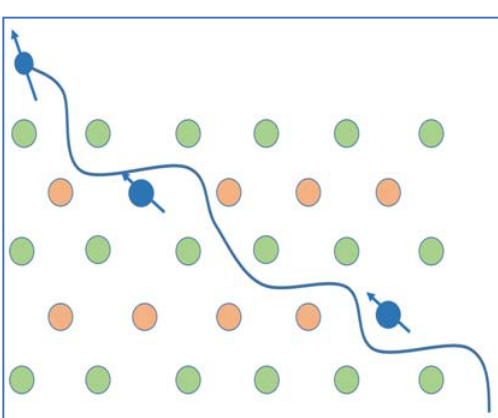
Figure 3. A schematic representation of ferromagnetism in Co:TiO 2 . The orange, green and blue spheres correspond to titanium, oxygen and cobalt atoms, respectively [27]. Appl. Sci. 2020 , 10 , x FOR PEER REVIEW